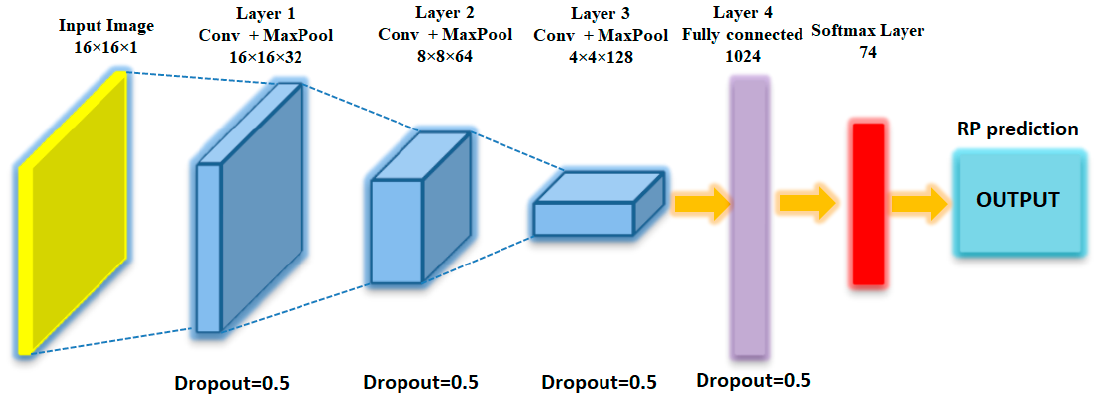
Figure 5. Network architecture for the deep learning classifier. Table 1. Summary of parameters used in the deep learning classifier.